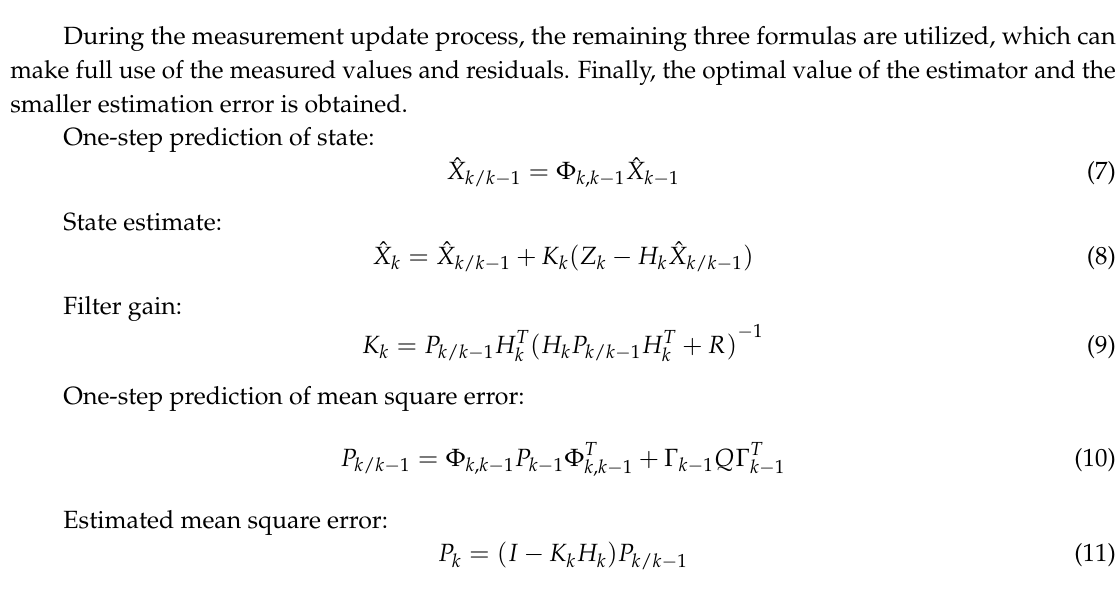
Figure 7. The Kalman filter (KF) process.